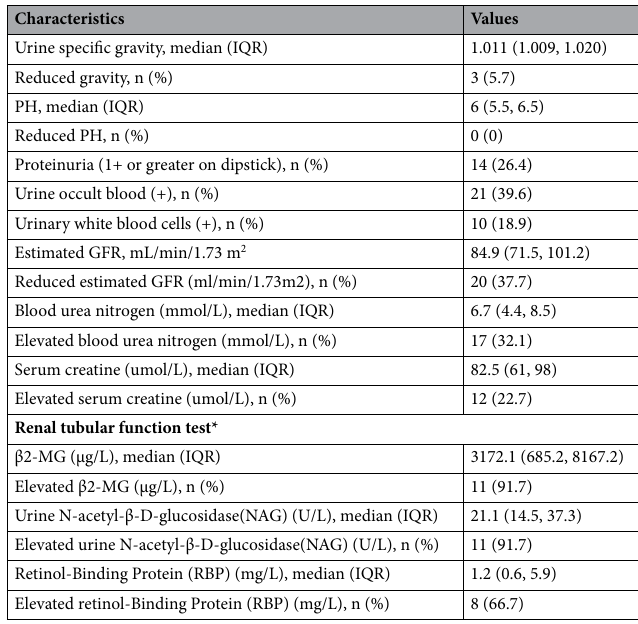
Table 2. Renal indexes in IgG4-RKD+ patients (n = 53). *Twelve (22.6%) of the 53 IgG4-RKD+ patients had been tested for renal tubular